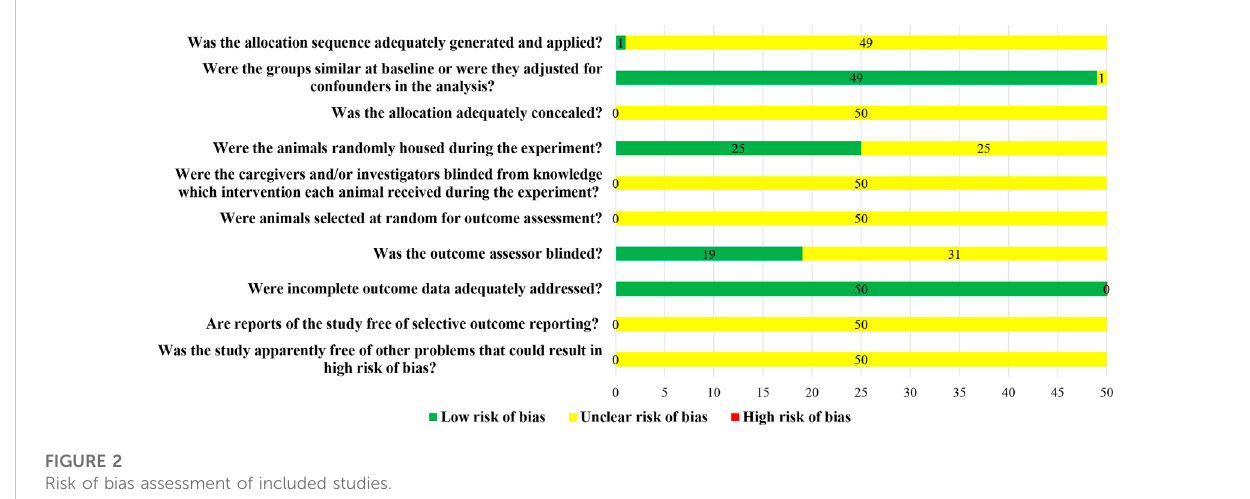
FIGURE 2 Risk of bias assessment of included studies.